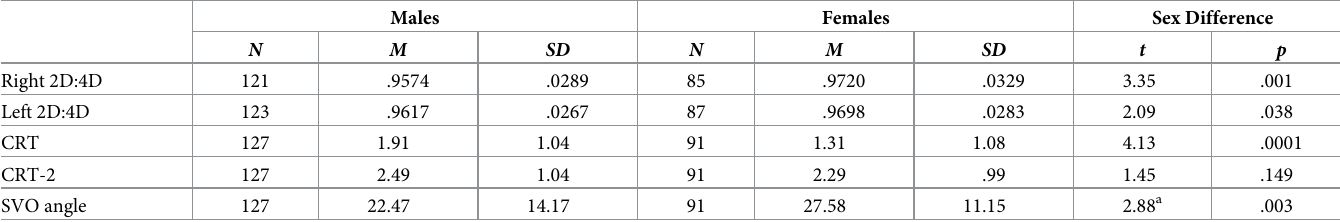
Table 1. Sex differences on the different